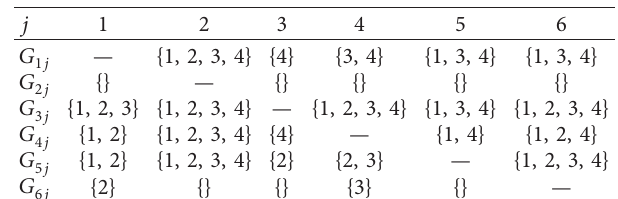
Table 4: 4F concordance set.